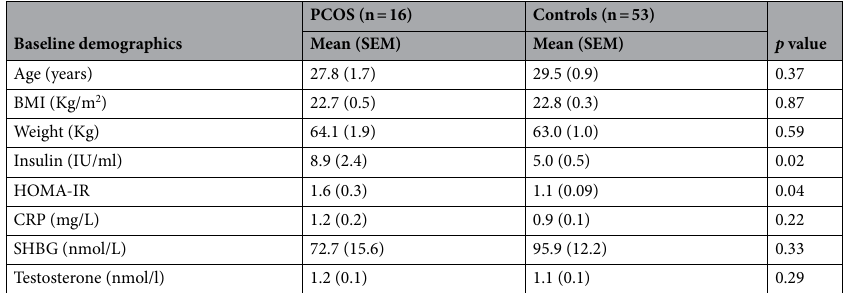
Table 3. Demographics, baseline, hormonal and metabolic parameters of the normal weight (BMI ≤ 25 kg/m 2